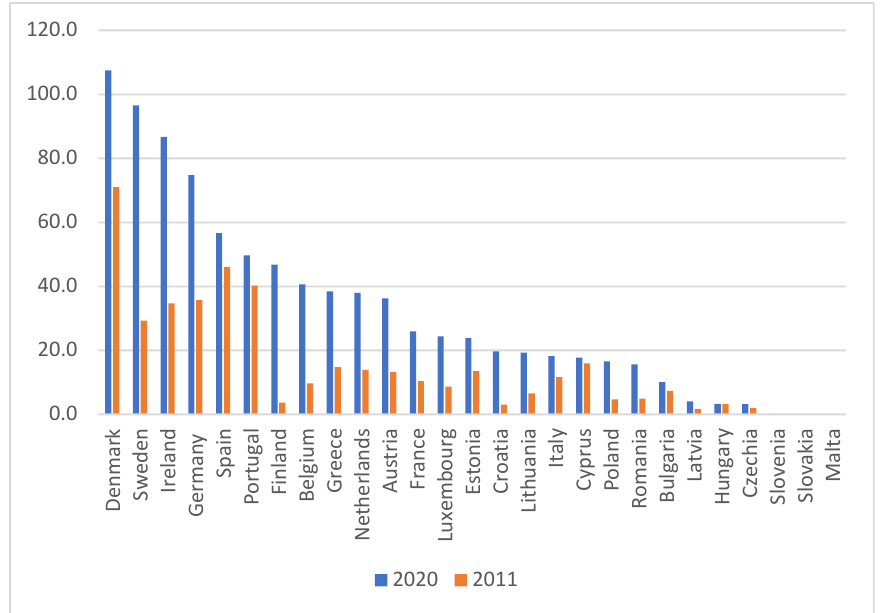
Figure 2. Energy production from renewable sources (wind energy in megawatts per 100,000 population) in EU countries in 2020 and 2011.